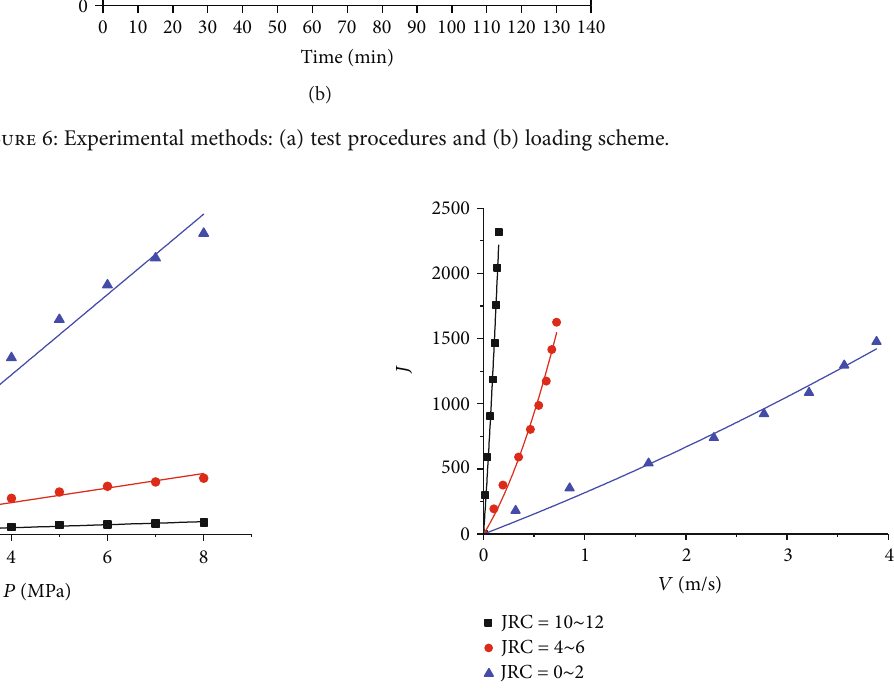
Figure 7: The measured and corresponding fi tted curves in the form of Q versus P for samples with di ff erent JRC .